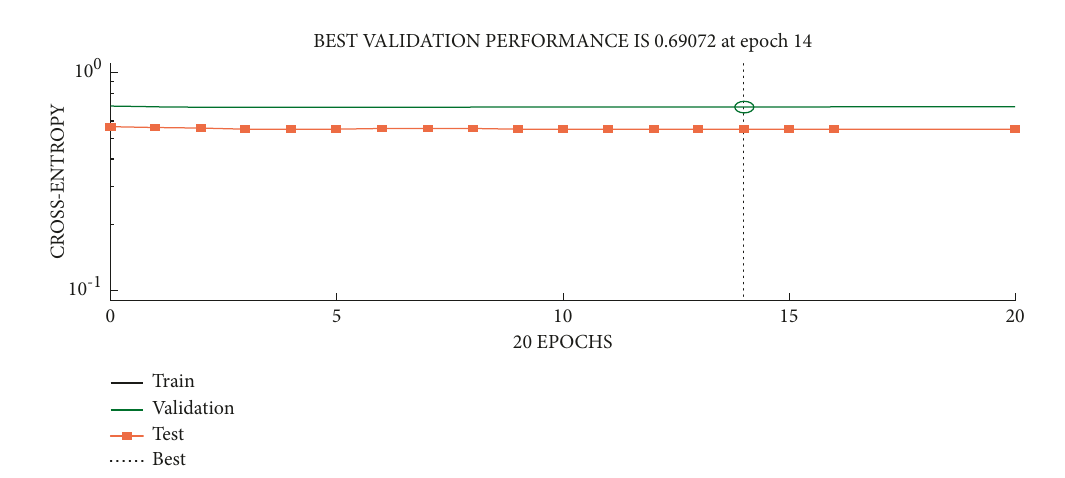
Figure 5: Performance plot.